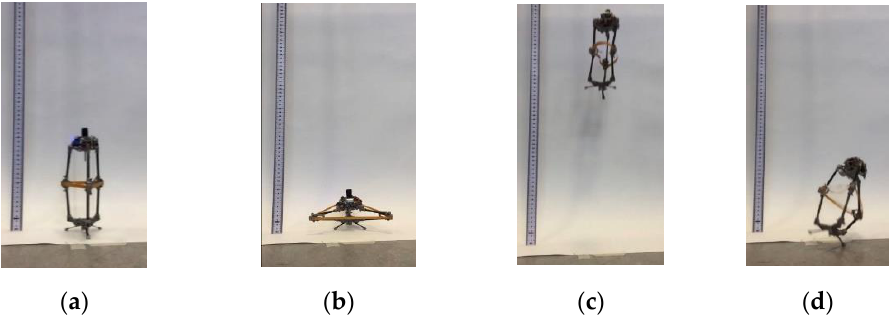
Figure 3. Jumping process of the prototype: ( a ) uncompressed state; ( b ) compressed state; ( c ) take-off state; ( d ) landing state.